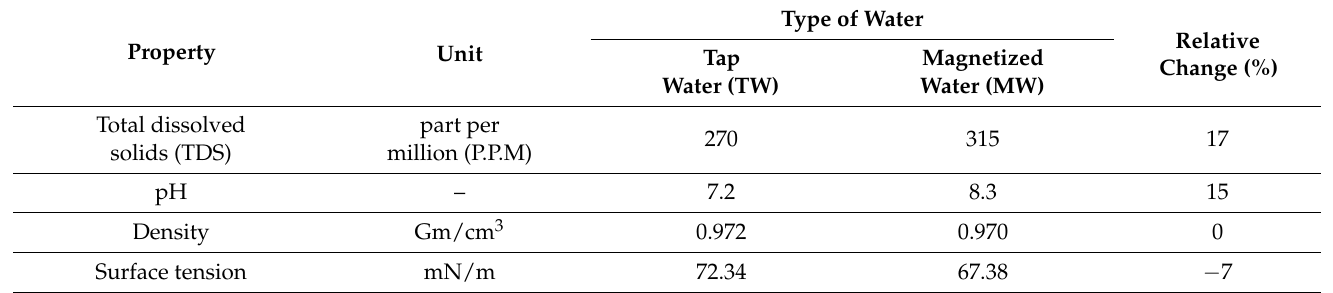
Table 6. Results of physical and chemical properties of